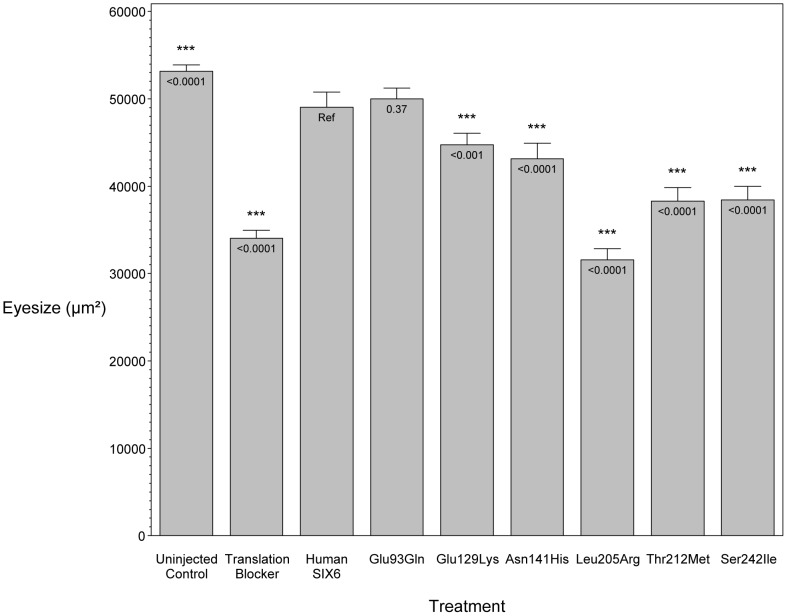

In vivo zebrafish morpholino complementation assay showing the effect of SIX6 nonsynonymous variants.Zebrafish embryos were microinjected with a translation blocking morpholino designed to target six6a. Total eye size (µm2) was measured 3 days post fertilization. Compared to the uninjected controls, morphants showed a significant reduction in eye size. Zebrafish were co-injected with the morpholino and a human SIX6 allele (Glu93Gln, Glu129Lys, Asn141His, Leu205Arg, Thr212Met, or Ser242IIe). Results of each allele were compared to the SIX6 non-risk allele (Ref). P-values are provided below the mean of each treatment.